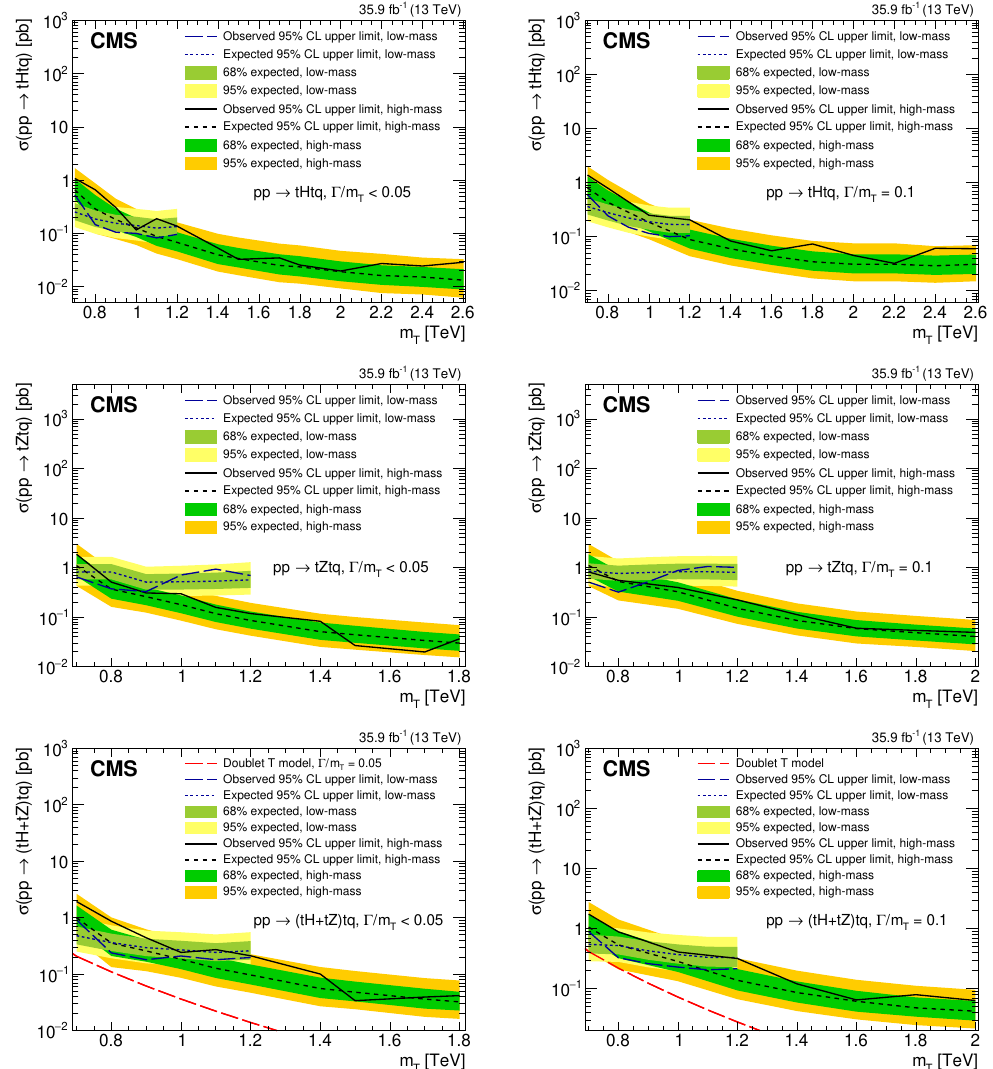
Figure 14 . The observed and median expected upper limits at 95% CL on the cross sections for production associated with a top quark for the tHtq (upper row) and tZtq (middle row) channels, and their sum, tHtq + tZtq (lower row), for di(cid:11)erent assumed values of the T quark mass. The inner (green) bands and the outer (yellow) bands indicate the regions containing 68 and 95%, respectively, of the distribution of limits expected under the background-only hypothesis. The left (cid:20) 0 : 05) and the right column is for a fractional column is for a narrow fractional width ((cid:0) =m T width of (cid:0) =m = 0 : 1. The dashed red curves are for the (TB) doublet model. Given the speci(cid:12)ed T width, the couplings are implicit in the